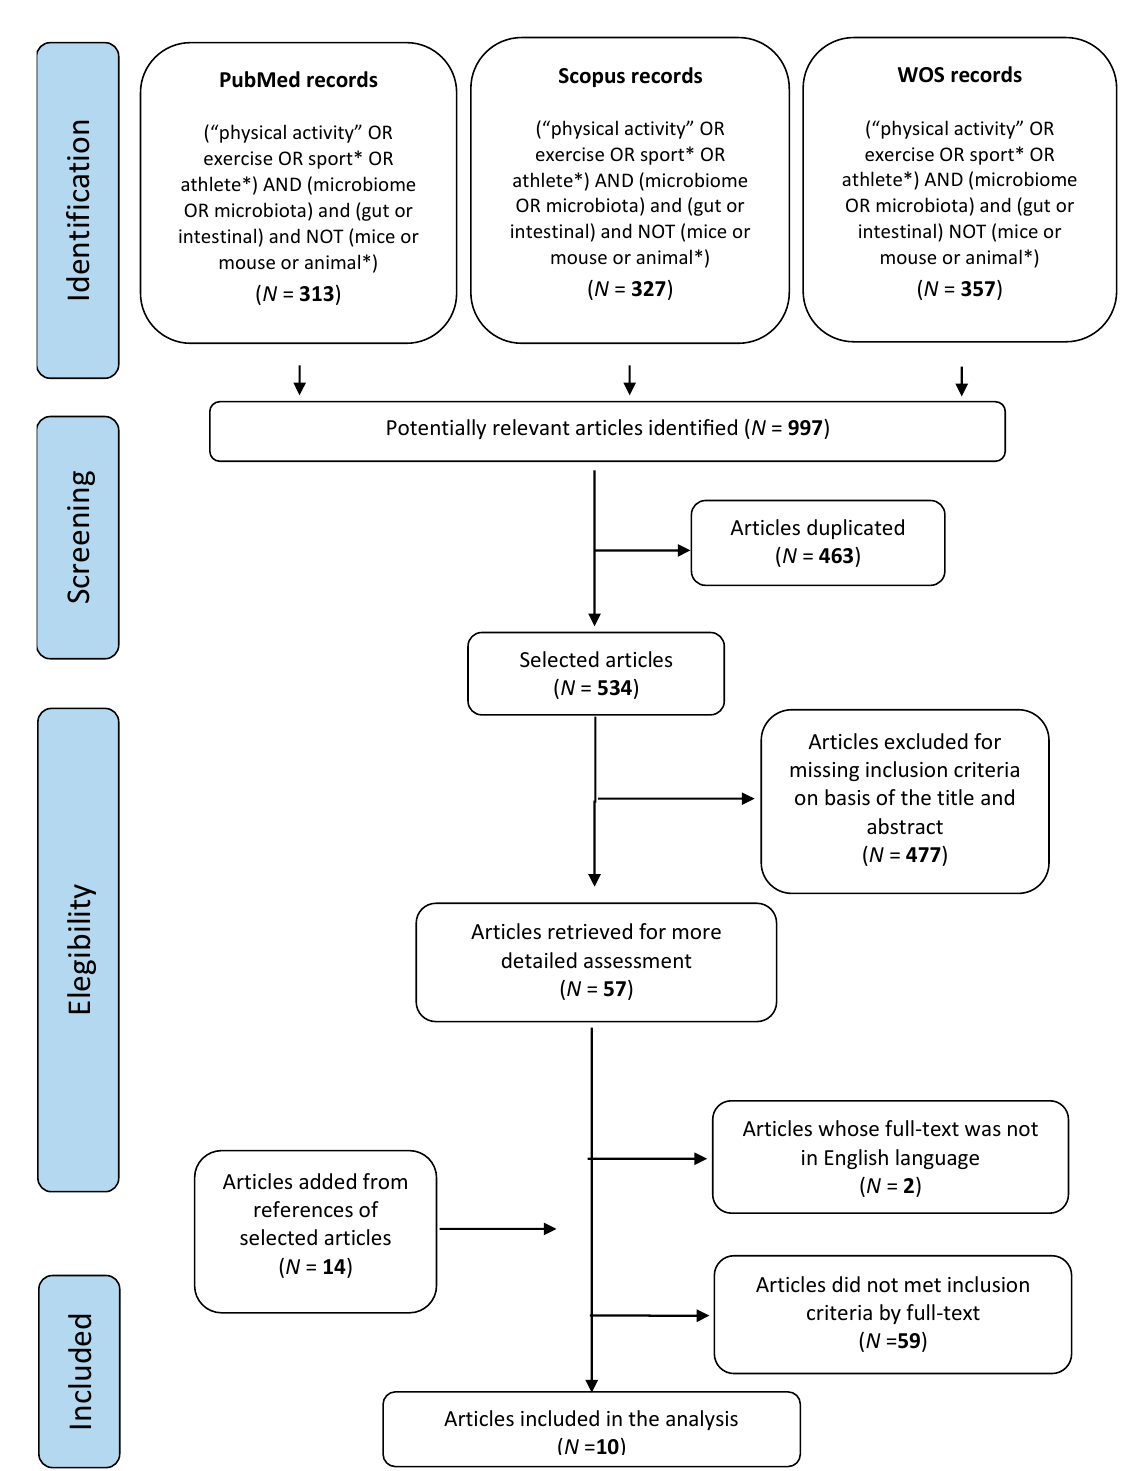
Figure 1. PRISMA flow diagram of the systematic review process.